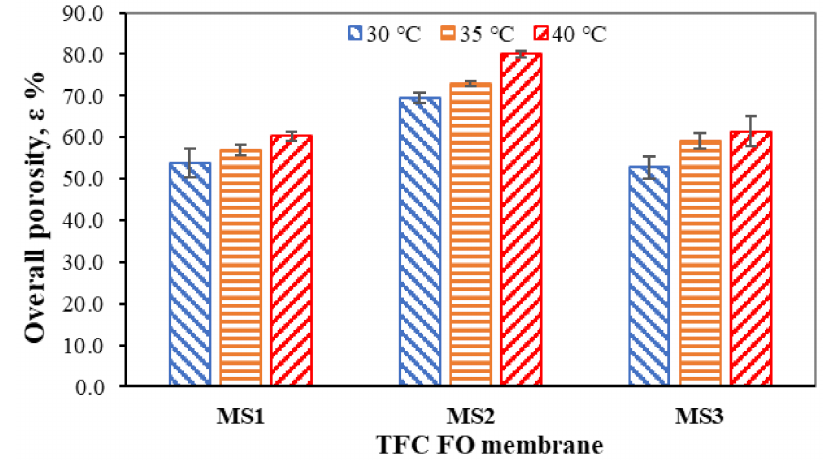
Figure 5. Overall porosities of the TFC FO